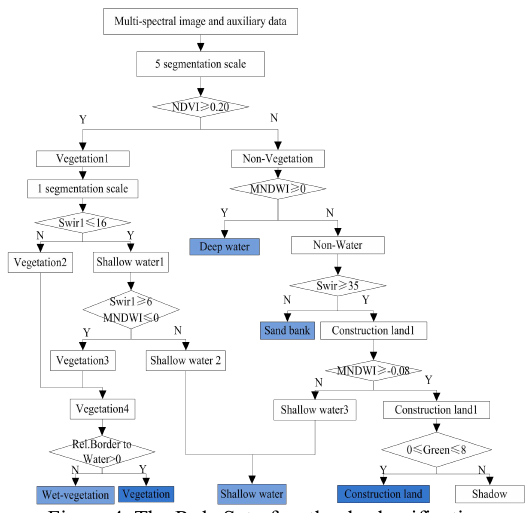
Figure 4. The Rule Set of wetlands classification The best segmentation scale provided by the repository for the ground features different from each other, stratified sub-scale method have more advantage for distinguishing the fine the image objects, such as small water, from the parent image vegetation and built area, deep water, sand beach were extracted, while only at the scale of 1 the small water bodies